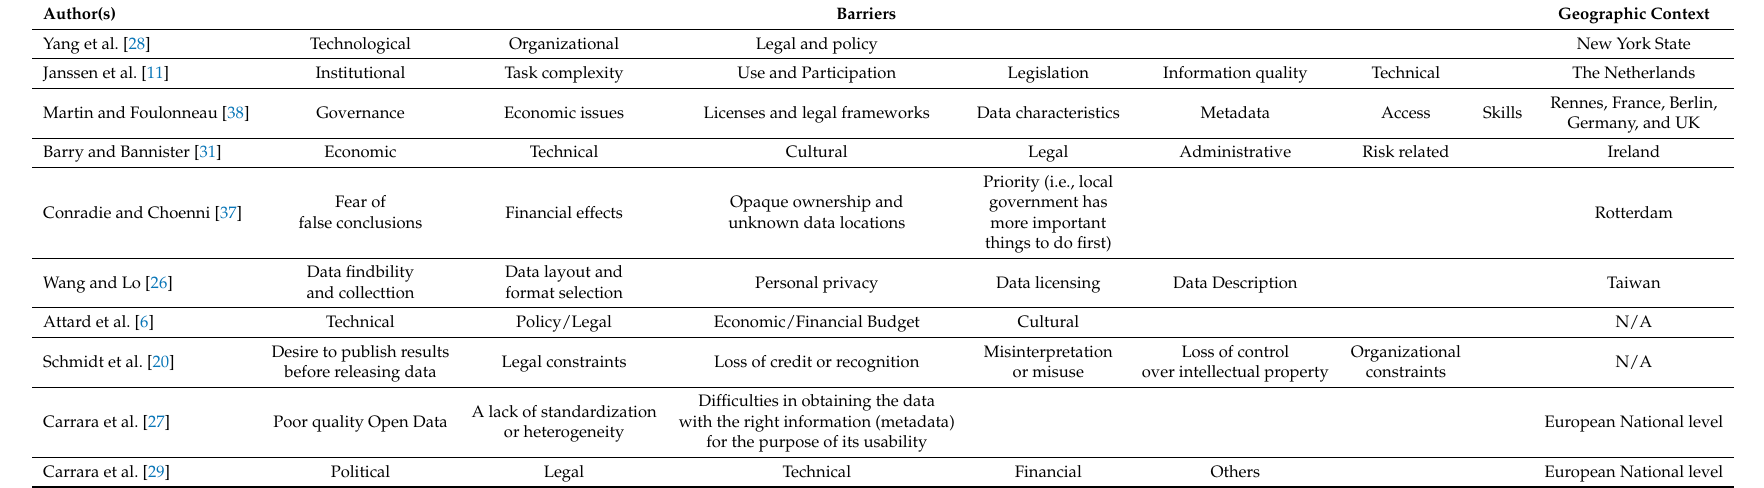
Table 2. This table represents the type of barriers to release data considering national or local use cases of open data initiatives, mentioned by each author. Due to there is no standard classification, barriers columns illustrate the barriers mentioned in each work, and at the same time the geographic context used for the use case. Note that mostly the national level is considered.